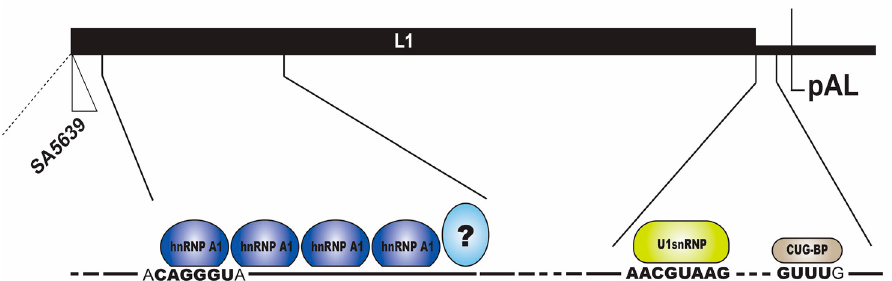
Figure 7. Schematic drawing of the late region of the HPV16 genome with the HPV16 3 ′ -splice site SA5639 and the late polyadenylation signal pAL and the late untranslated region (UTR). The blow up shows the splicing silencer elements downstream of the suppressed HPV16 late 3 ′ -splice site SA5639 [6,59,60]. These RNA elements consist of purine-rich sequences that bind hnRNP A1 [6,9,58–60]. Question marks indicate unidentified cellular proteins that bind to the splicing silencer. In addition to the splicing silencer elements downstream of SA5639, the HPV16 late mRNAs encode a negative regulatory element in the HPV16 late untranslated region [62]. The late UTR of many HPVs has an inhibitory function [63]. These elements consist of 5 ′ -splice site-like sequences that bind to U1 small nuclear ribonucleoprotein (snRNP) to inhibit HPV16 late polyadenylation [64,65], and GU-rich elements that bind CUG-triplet repeat RNA binding protein (CUG-BP) [66], and other proteins [62]. Binding sites for hnRNP A1, U1 snRNP and CUG-BP are in boldface.